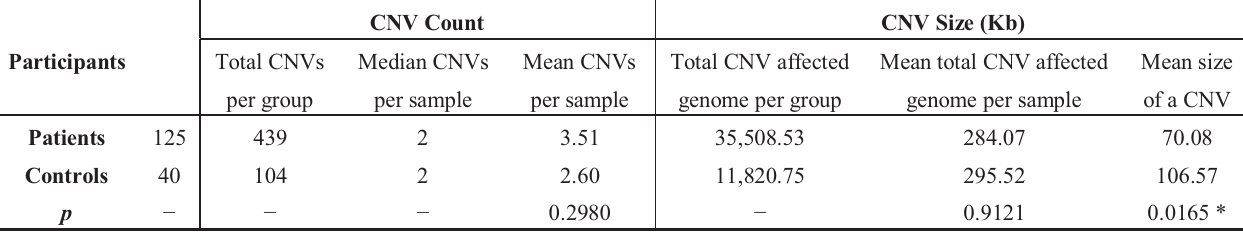
Table 1. Summary of copy number variants (CNV) results obtained from the Cyto2.7M array analysed in